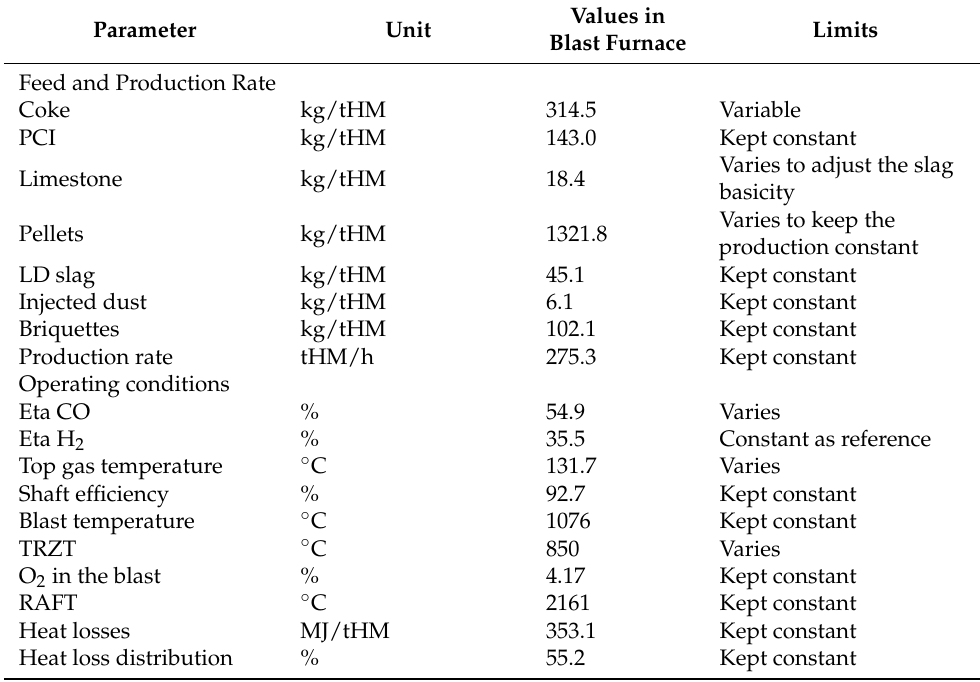
Table 7. Set-up parameters for